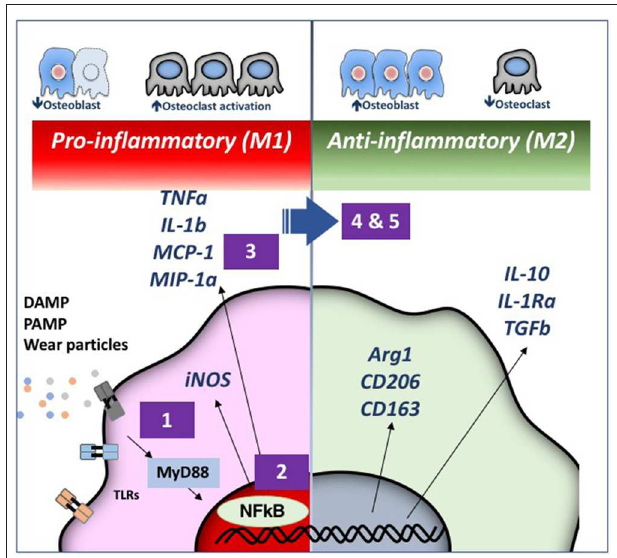
FIGURE 3 | Strategies for immunomodulation to mitigate periprosthetic osteolysis induced by wear particles. Wear particles and adherent pathogen-associated molecular patterns (PAMPs) and byproducts of cell death and tissue injury (damage-associated molecular patterns or DAMPS) can be recognized by Toll-like Receptors (TLRs) and other receptors on macrophages, which then activate downstream pathways including the key transcription factor Nuclear Factor-kappa B (NF κ B). The induced pro-inflammatory responses driven by NF κ B activation include the expression of inducible nitric oxide synthetase (iNOS) and cytokines/chemokines including Tumor Necrosis Factor alpha (TNF α ), Interleukin 1 beta (IL-1b), Macrophage Chemotactic Protein 1 (MCP-1), Macrophage Inhibitory Protein 1 alpha (MIP-1 α ), and others. These events may lead to periprosthetic osteolysis due to reduced osteoblast and increased osteoclast activity. We have demonstrated that the particle-induced osteolysis can be mitigated by inhibiting (1) the TLR pathway; (2) NF κ B activation; or (3) macrophage migration using a mutant MCP-1 called 7ND recombinant protein. Alternatively, pro-inflammatory macrophages (M1, Left ) can be polarized by (4) Interleukin 4 (IL-4) treatment or (5) genetically modified or preconditioned mesenchymal stem cells (MSCs) (see Figure 4 for details) into an anti-inflammatory, pro-tissue repair macrophage (M2) phenotype ( Right ). M2 macrophages are identified by their expression of Arginase 1 (Arg1) and the surface markers CD206 and CD163. M2 macrophages produce Interleukin 10 (IL-10), IL-1 receptor antagonist (IL-1ra), and Transforming Growth Factor beta (TGF β ). Myeloid Differentiation primary response 88 (MyD88) is a universal adapter protein that is downstream of nearly all TLRs (except TLR3), and leads to activation of NF κ